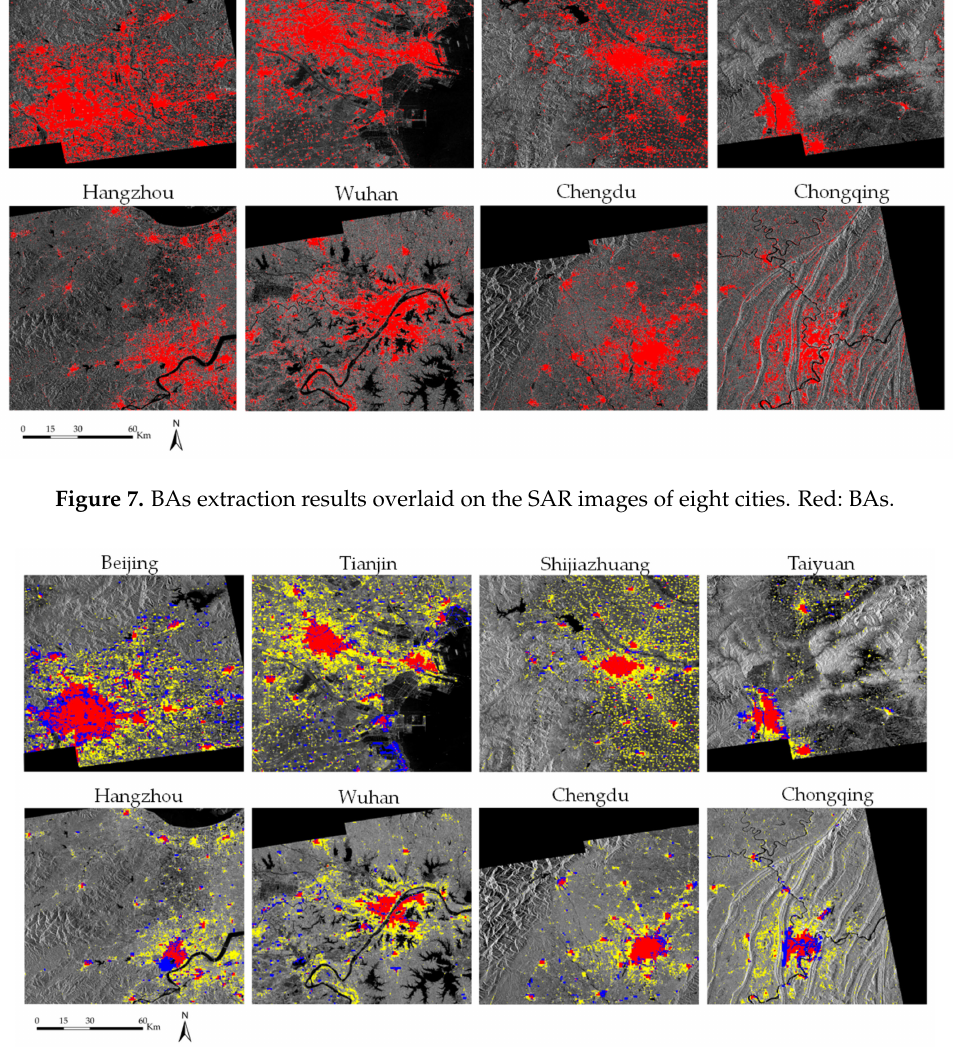
Figure 8. BAs extraction results of the proposed method and the GlobCover urban map overlaid on the resampled SAR images. Red: BAs extracted by the two; Yellow: BAs detected by proposed method and missed by GlobCover (omission-prone areas of GlobCvoer); Blue: BAs extracted by GlobCover and missed by our results (commission-prone areas of GlobCover and omission-prone areas of our results). Table 7. Accuracy comparison of results based on proposed method and GlobCover urban map. Overall BAs Commission BAs Omission Cities BAs Extraction Kappa Accuracy (%) Error (%) Error (%) Beijing